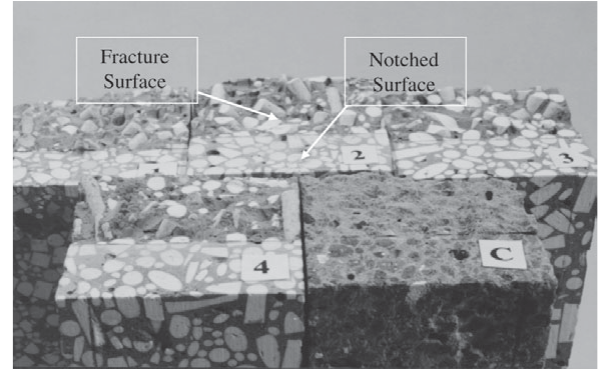
Figure 7. SEM Micrograph of the fracture surface of an unfired specimen – Aspect ratio 3. Longitudinal crack right at the aggre- gate/matrix interface (1000×)